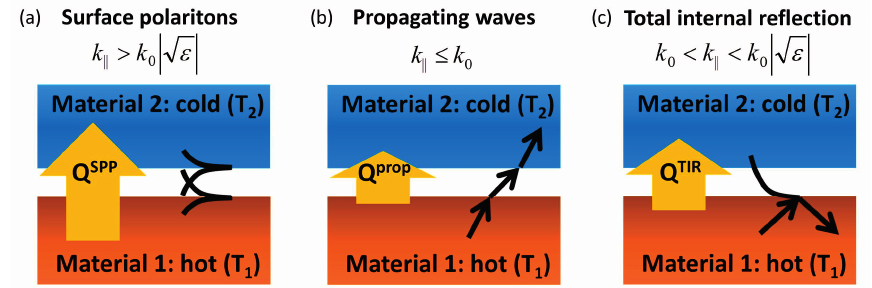
Figure 1. A schematic of the near-field radiative heat exchange between a parallel-plate emitter (medium 1) and absorber (medium 2) across the vacuum gap (medium 0). Heat transfer between the hot and cold sides mediated by ( a ) evanescently-coupled surface polariton modes (if supported by the materials), ( b ) propagating waves in the vacuum gap, and ( c ) evanescent fields created by the total internal reflection of propagating waves within the emitter